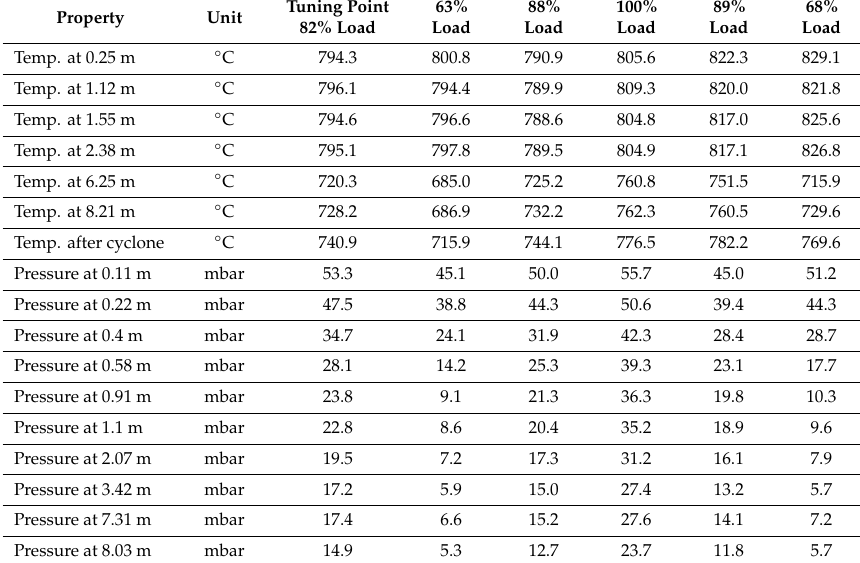
Table A1. Test results at steady-state and